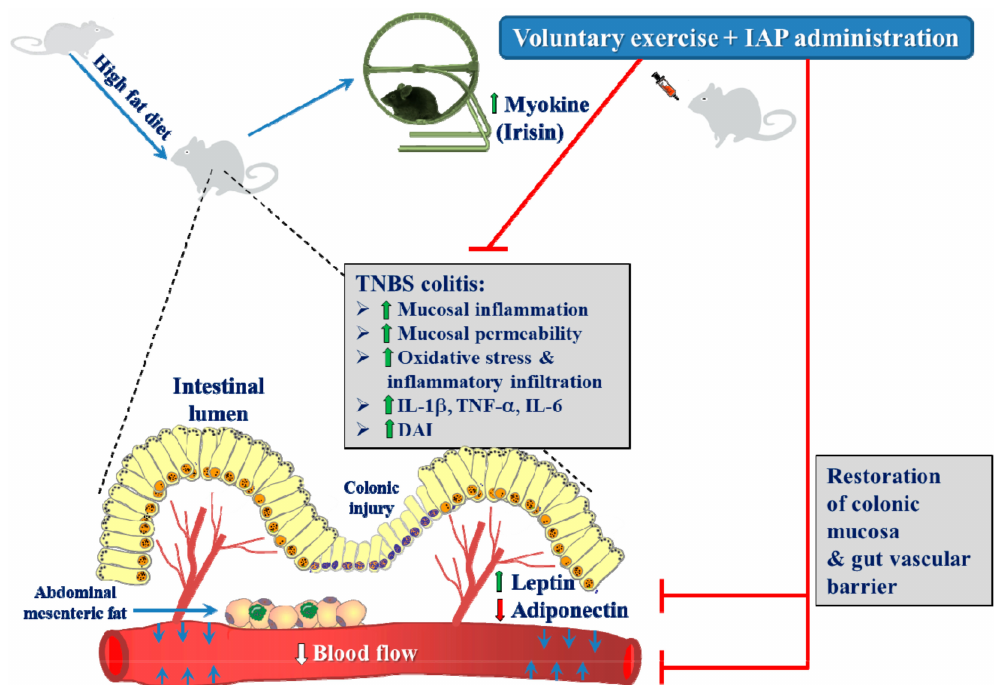
Figure 7. The summary scheme of the beneficial effect exhibited by the combination of IAP treatment with moderate physical activity in the mechanism of the healing of experimental colitis in mice fed HFD. The mucosal damage and an impairment in the colonic microcirculation and downregulation of antioxidative biomarkers induced by TNBS accompanied by mucosal inflammation and oxidative stress are restored by the combination of IAP and voluntary exercise due to better restoration of colonic mucosa and an improvement of gut vascular barrier caused by antioxidative myokines and